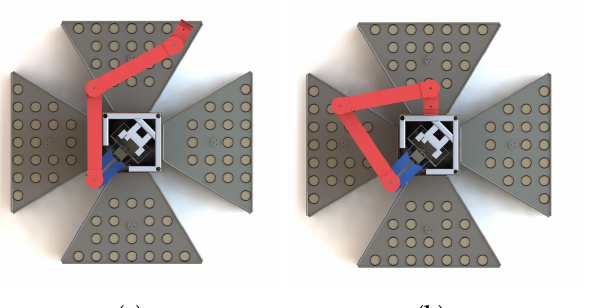
Figure 5. Manipulator orientations (top view): ( a ) reaching the furthest point; ( b ) SEM mounting orientation.